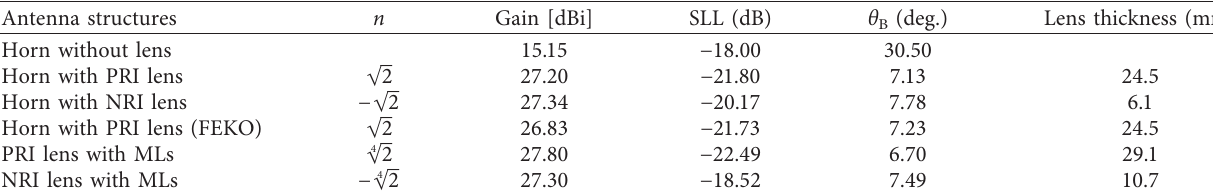
Table 3: Comparison results.